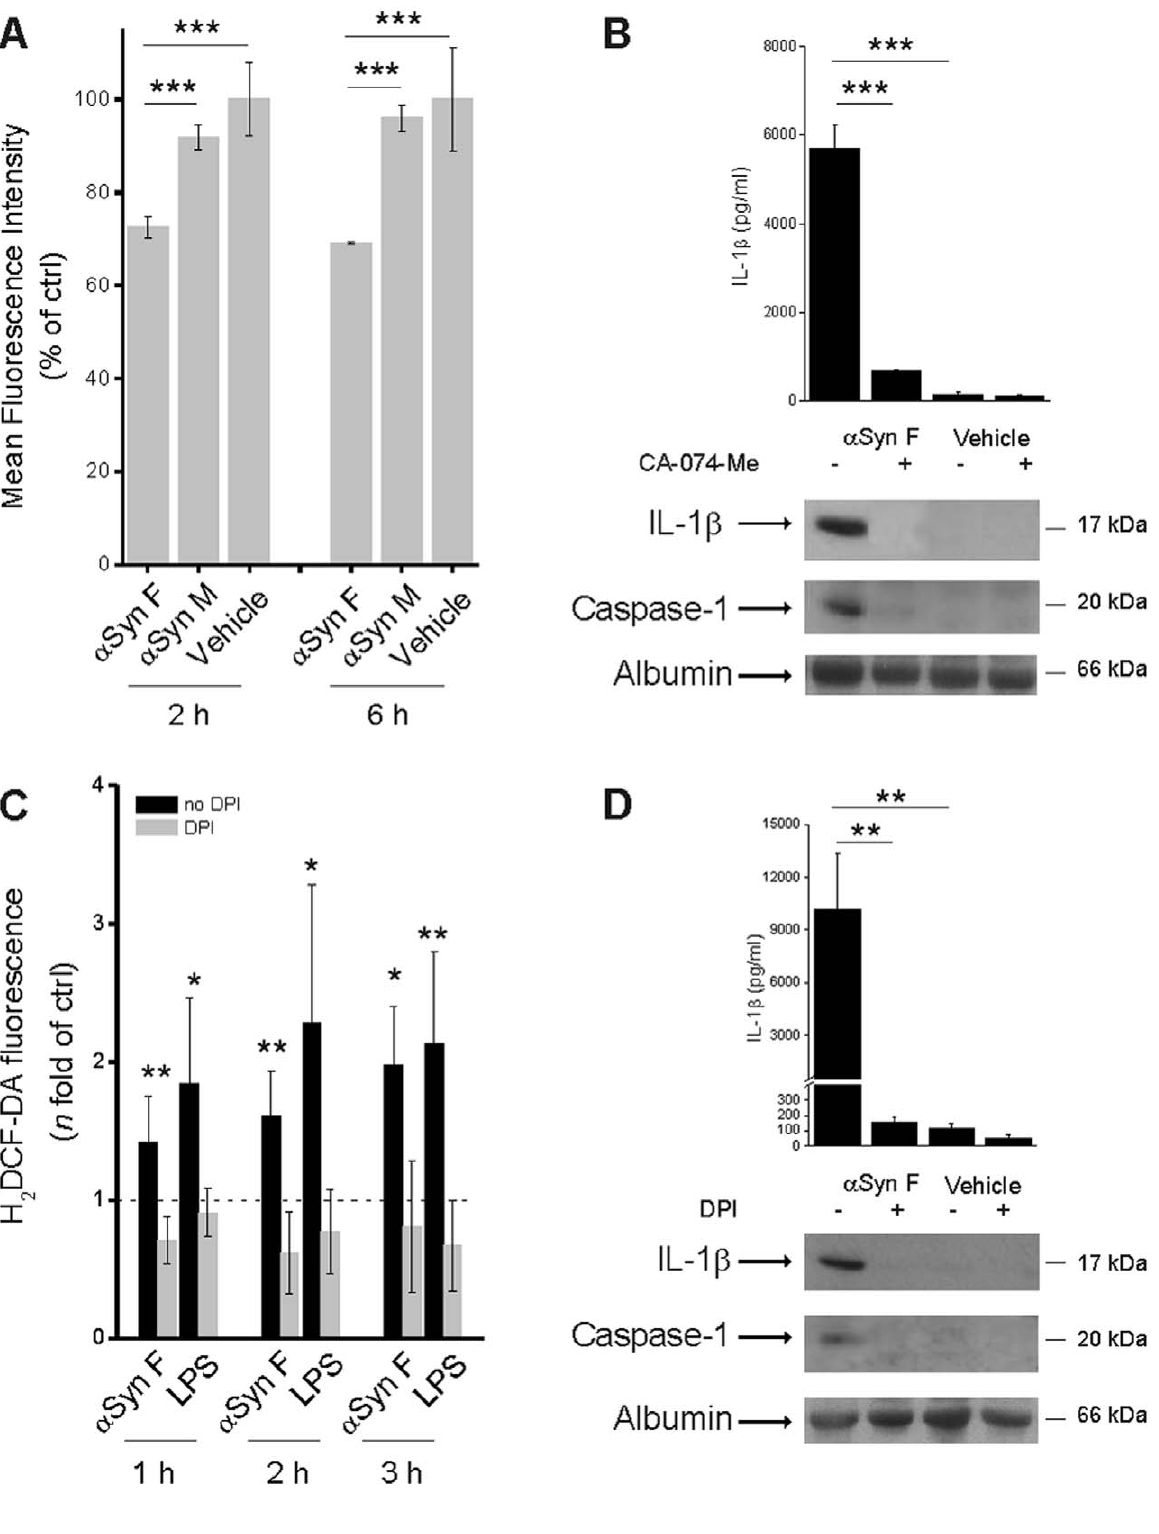
Figure 4. Cathepsin B activity as well as ROS production are involved in a Syn F-induced inflammasome activation. (A) Phagocytosis of fibrillar a Syn leads to phago-lysosomal destabilization. Flow cytometry of monocytes stained with acridine orange and then treated for 2 or 6 h with 40 nM a Syn F, 1 m M a Syn M. Data are reported as the percentage of acridine orange-positive cells present in the vehicle-exposed sample. Results are the mean 6 S.D. of 3 experiments conducted in duplicate with cell preparations obtained from 3 different donors. *** p , 0.001. (B) Monocytes were incubated for 30 min with 10 m M CA-074-Me (an inhibitor of cathepsin B), or left untreated; cells were then exposed for 6 h to 40 nM a Syn F or vehicle. IL-1 b released into the culture supernatants was evaluated both by ELISA and immunoblot analysis. The same supernatants were assessed for